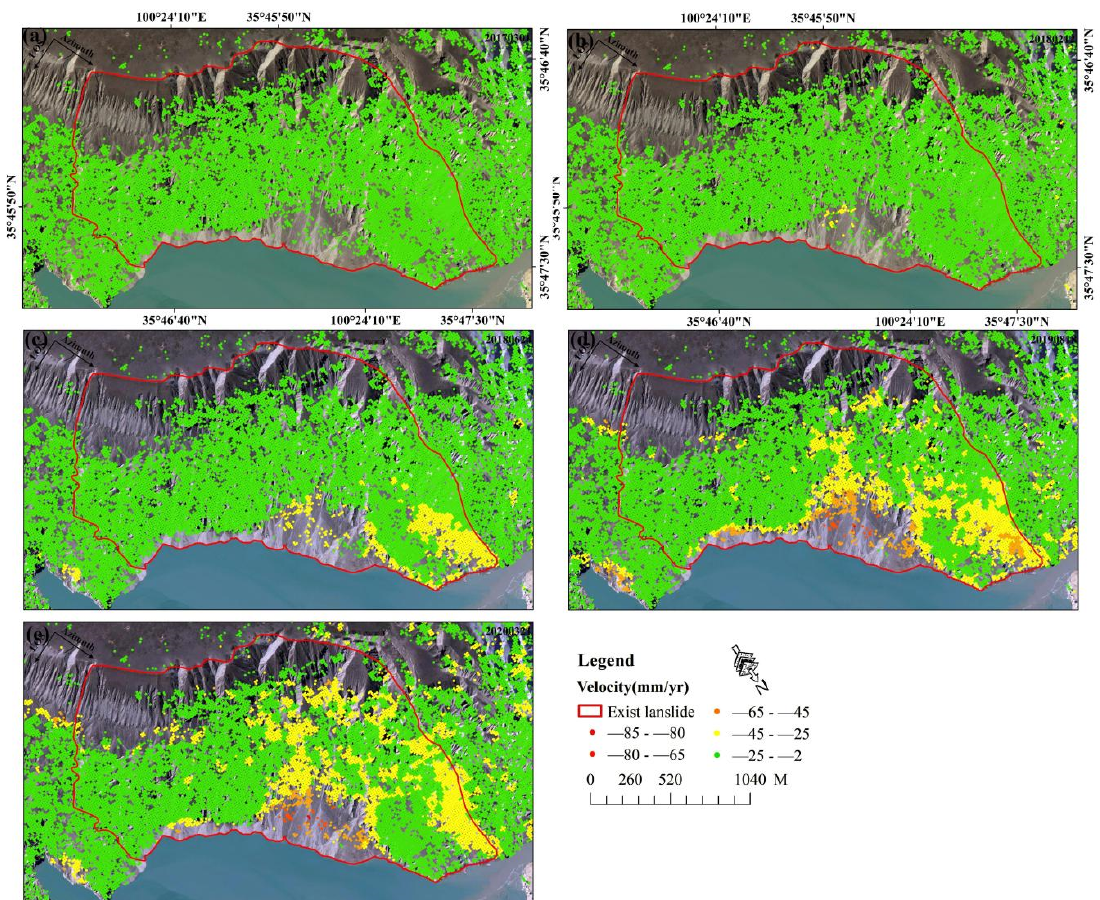
Figure 16. Spatial deformation characteristics of the Mangla River Estuary landslide. ( a ) Cumulative displacement of Mangla River Estuary landslide on 1 March 2017, ( b ) Cumulative displacement of Mangla River Estuary landslide on 12 February 2018, ( c ) Cumulative displacement of Mangla River Estuary landslide on 24 June 2018, ( d ) Cumulative displacement of Mangla River Estuary landslide on 18 August 2019, ( e ) Cumulative displacement of Mangla River Estuary landslide on 21 March 2020.